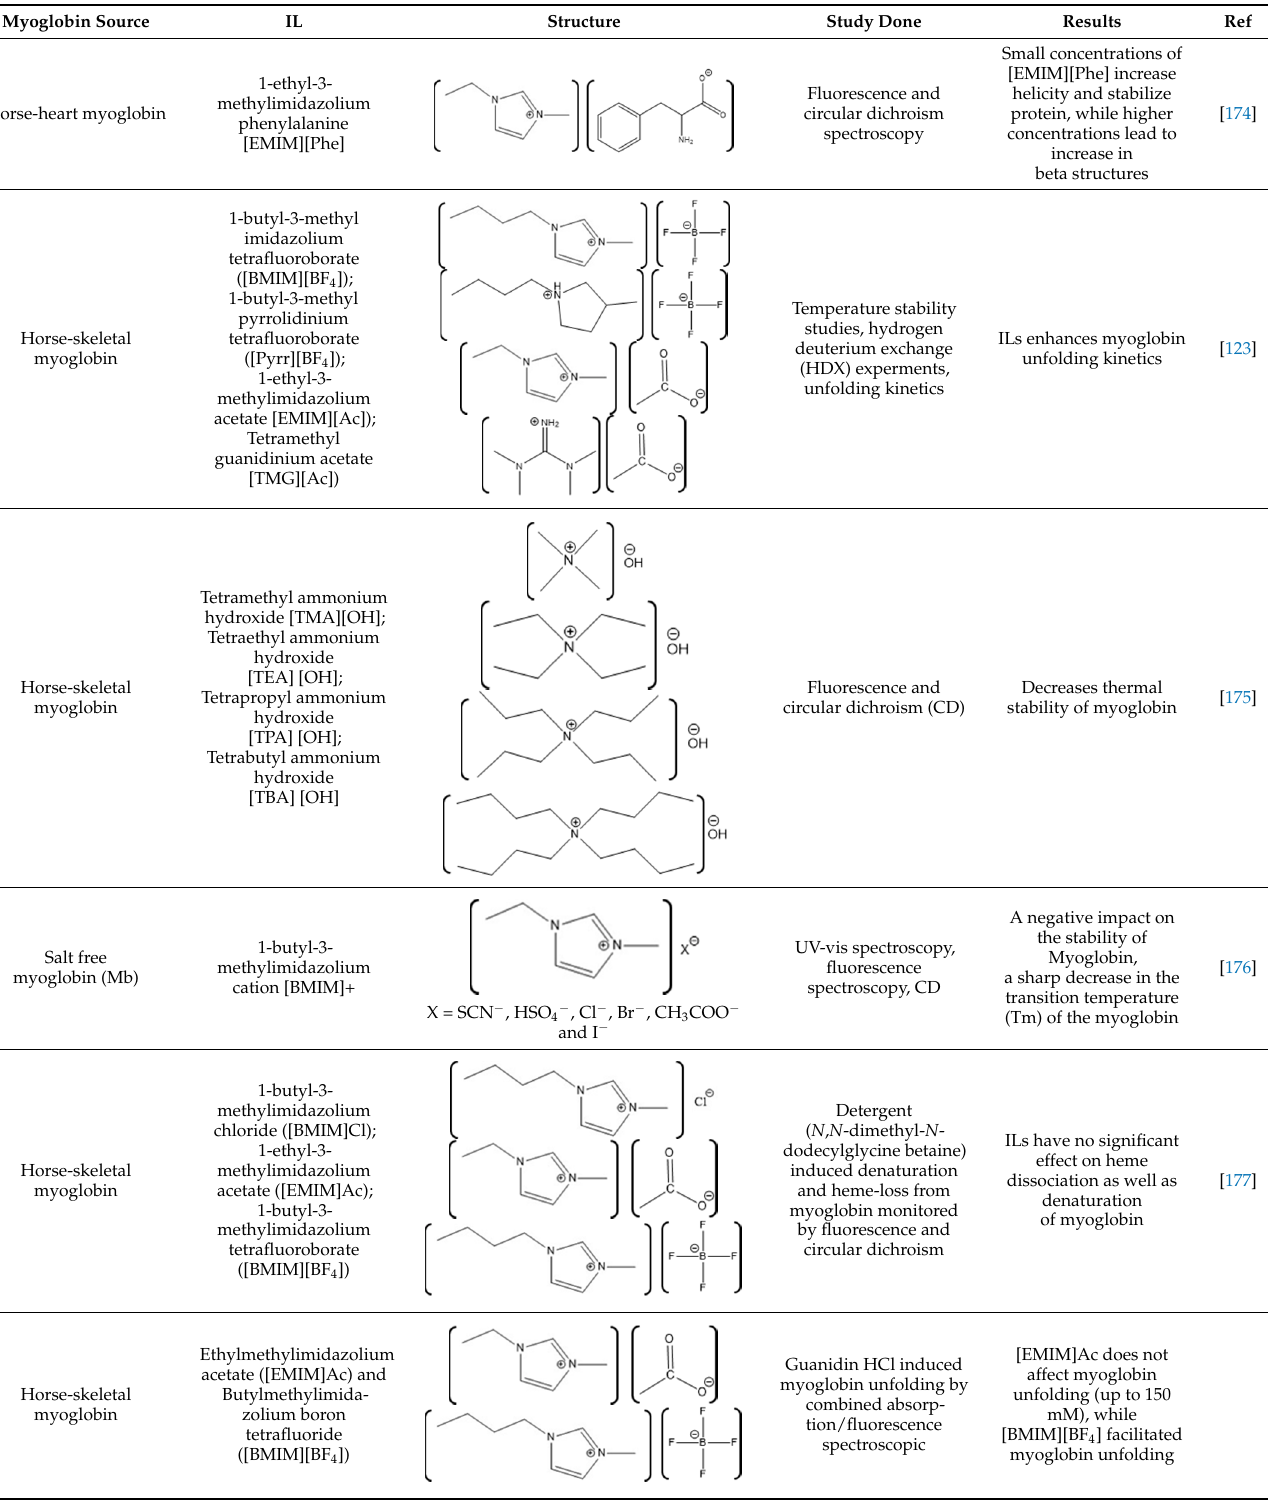
Table 2. Summary of studies done pertaining to monitoring the effects of ILs on myoglobin.